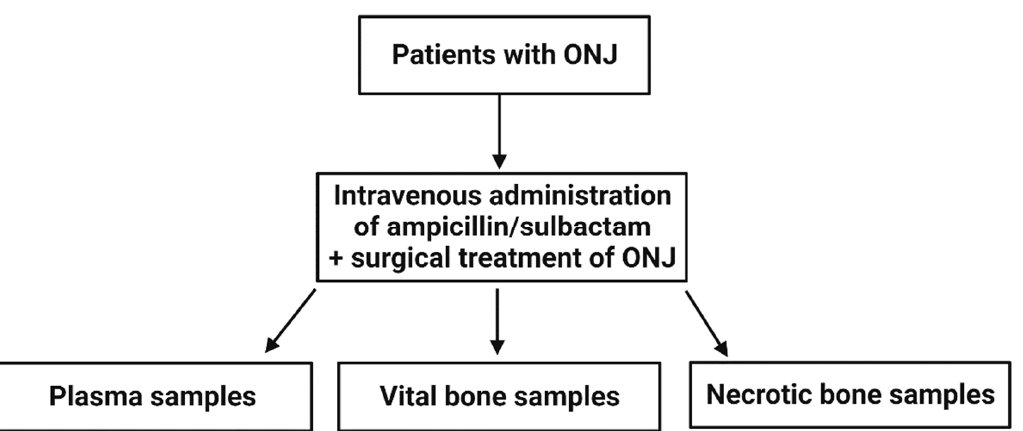
Figure 1. Flowchart—all consenting patients with osteonecrosis of the jaw (ONJ) either after radiation of the head and neck area or after the intake of antiresorptive agents were included in the study when inclusion criteria matched. Where possible, a plasma sample as well as necrotic and vital bone sample were collected from each patient.